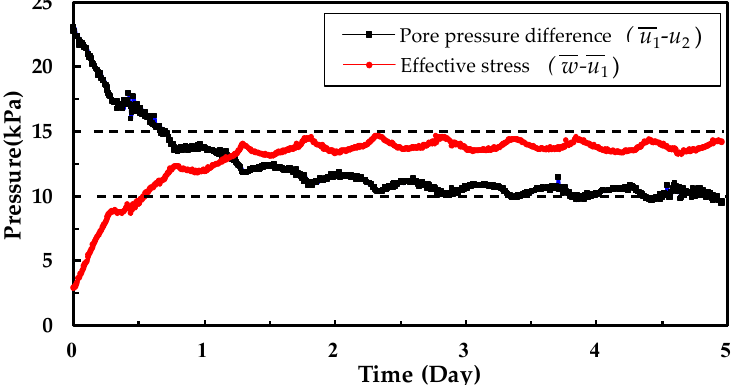
Figure 6. Variation of the pore pressure difference and effective stress during the sitting time of 5 days.